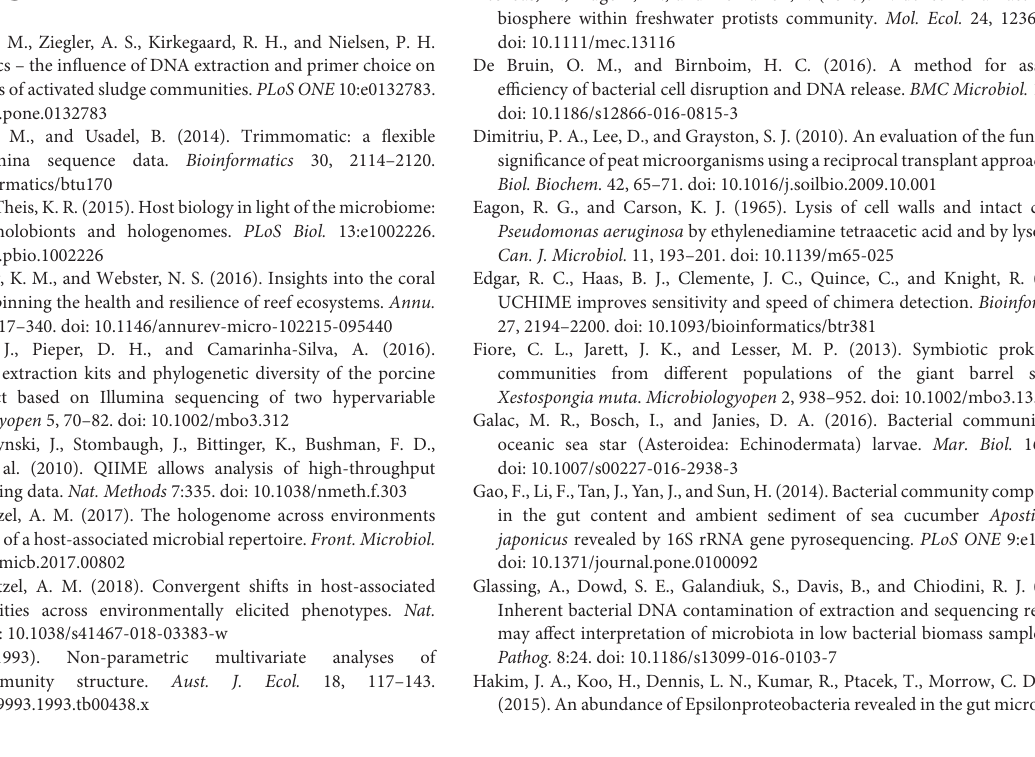
individual sample and each line connects one individual’s tissue subjected to the three DNA extraction methods. Supplemental Table 1 | Complete list of all OTUs deleted from our analysis due to their presence in blank sequences. Table contains taxonomic assignment and mean number of sequence reads in each method and blank sample. Supplemental Table 2 | Meta-data for marine microbial publication data synthesis including; taxonomic group, kit used, extraction method, and publication information. Supplemental Table 3 | Meta-data for marine microbial publication data synthesis including; taxonomic group, sequencing method, and region